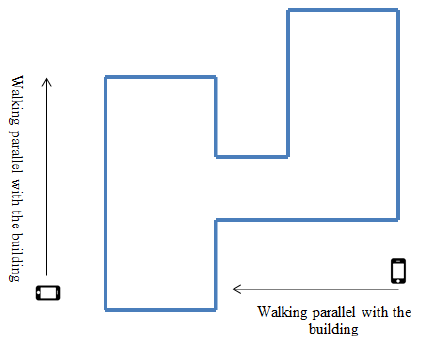
Figure 10 Illustration of the position of camera and how camera video records the building parts